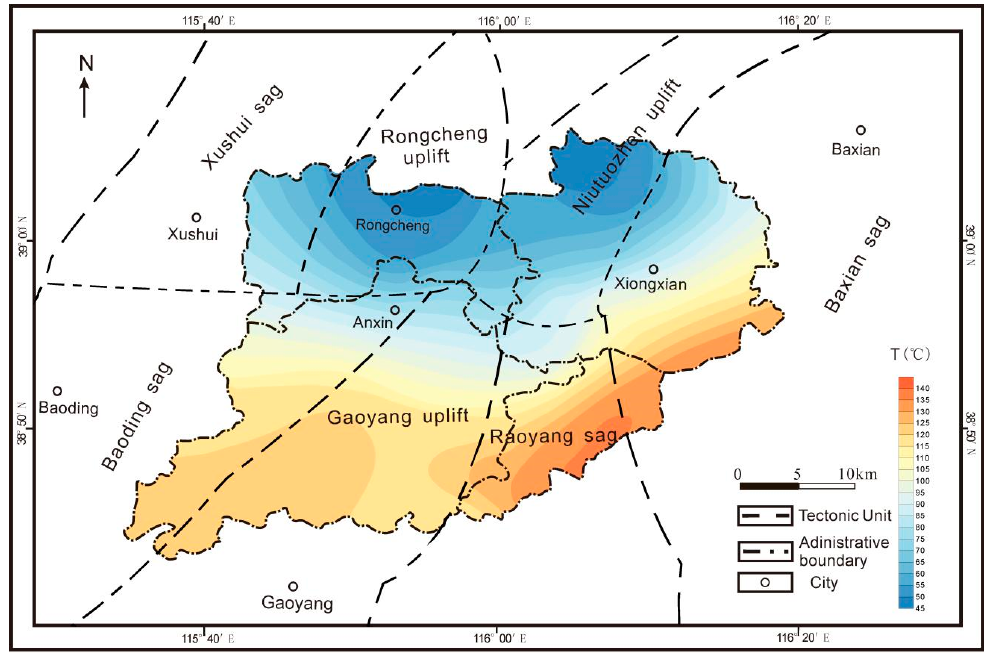
Figure 9. Calculated top surface temperature distribution of the Jxw Formation in the Xiong’an New Area.